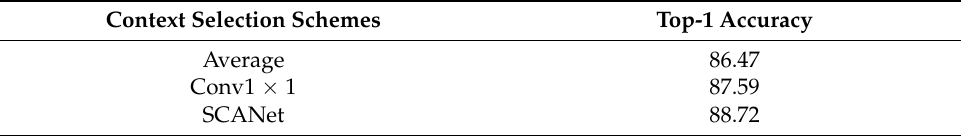
Table 3. Ablation study of the context selection mechanism.